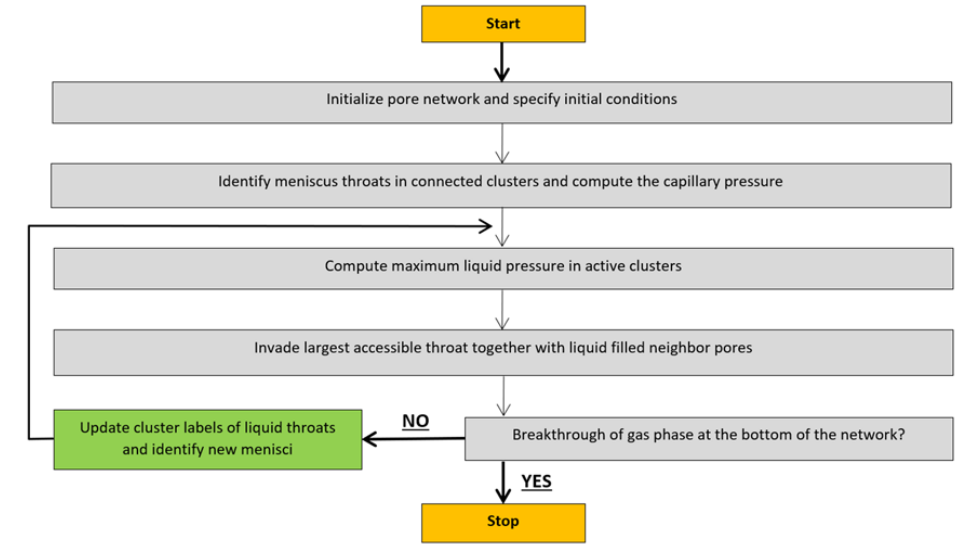
Figure 4. Scheme of the algorithm.